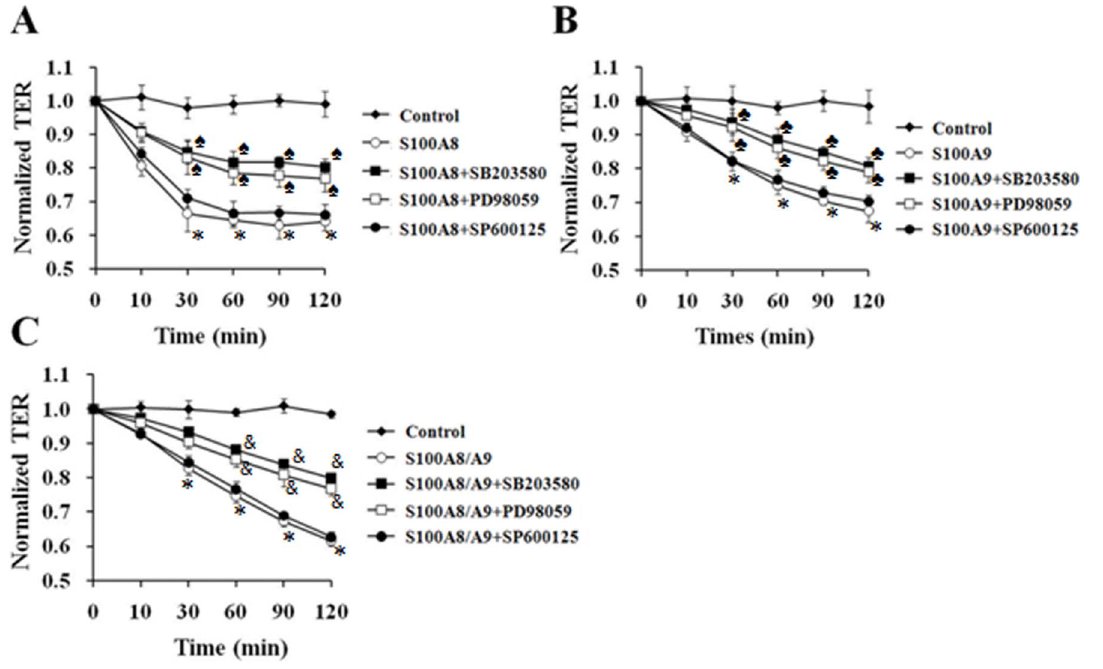
Figure 4. S100A8, S100A9 and S100A8/A9 induced increase in HUVEC permeability by a p38 and ERK1/2 dependent mechanism. HUVECs were stimulated with S100A8 (2.0 m g/mL) ( A ), S100A9 (2.0 m g/mL) ( B ) or S100A8/A9 (2.0 m g/mL) ( C ) for 120 min, with or without 60 min pre- incubated with SB203580, PD98059 and SP600125 which were used as standard inhibitor for p38, ERK1/2 and JNK, respectively. Then the TER was measured. All data are presented as mean 6 s.d. of four independent experiments. * P , 0.05 vs. Control, & P , 0.05 vs. S100A8, § P , 0.05 vs. S100A9, & P , 0.05 vs. S100A8/A9.